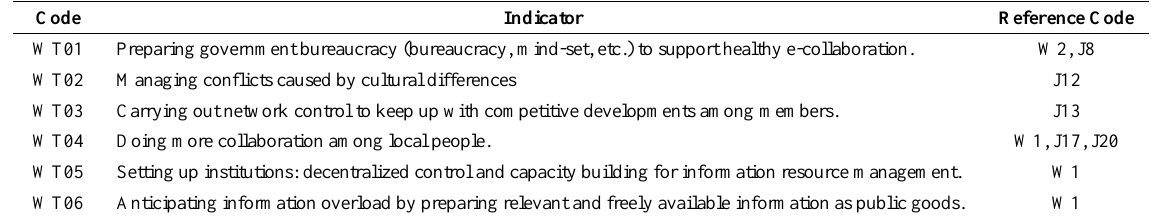
Table 8. The WT Strategy (Weakness-Threats Strategy).